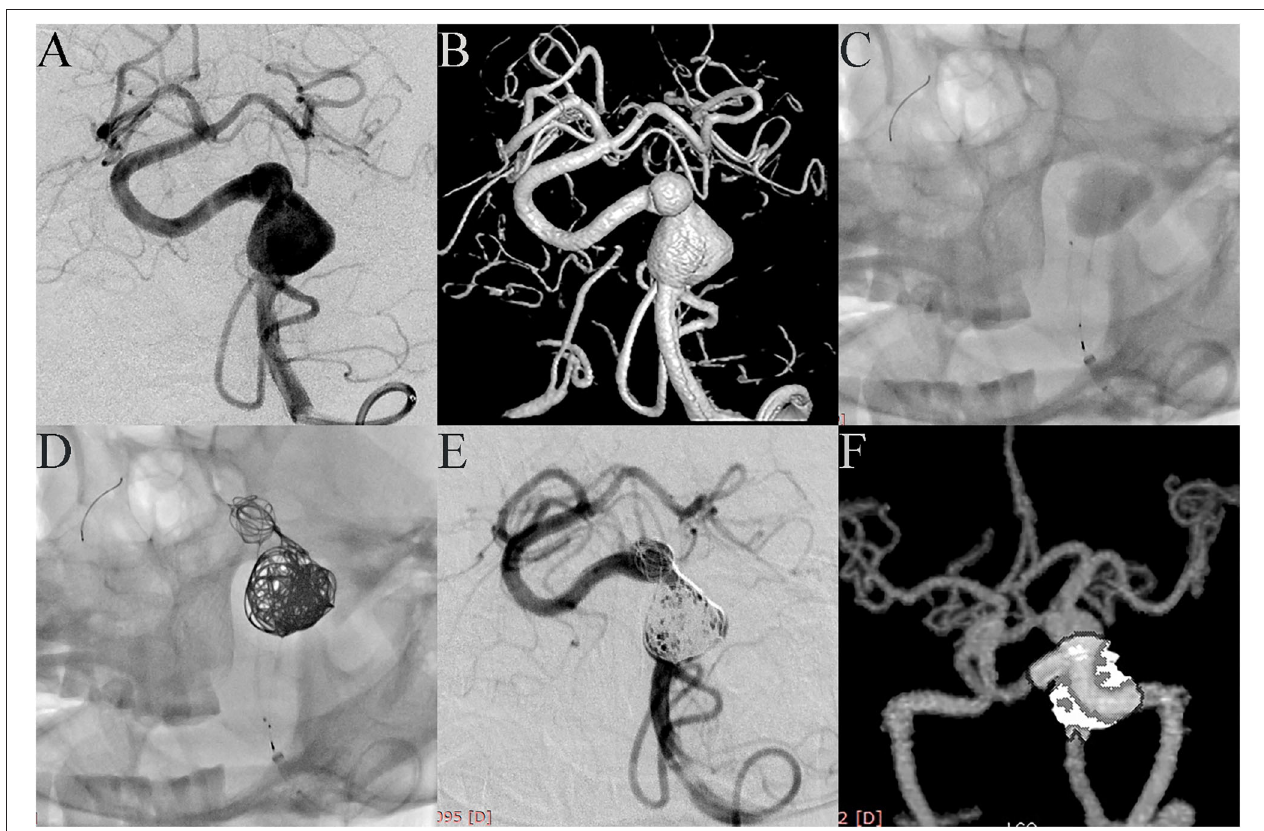
FIGURE 1 | Case 4: Two adjacent fusiform aneurysms were found in the left vertebral artery. ( A , anteroposterior projection by DSA; B , three-dimensional reconstruction). One PED was deployed along the left vertebral artery (C) , and both aneurysmal necks were completely covered. Two aneurysm domes were then packed with coils (D) . Post-embolization angiograms showed good vascular reconstruction. The large aneurysm was almost completely embolized and the small aneurysm showed significant contrast stasis (E) . Follow-up at 10 months with CTA showed complete reconstruction of the vessel with the aneurysm completely occluded (F)